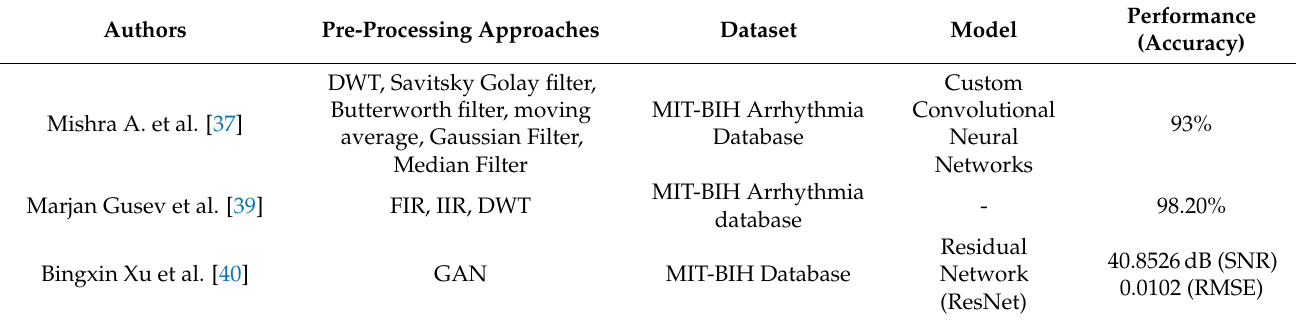
Table 1. Summary of the literature